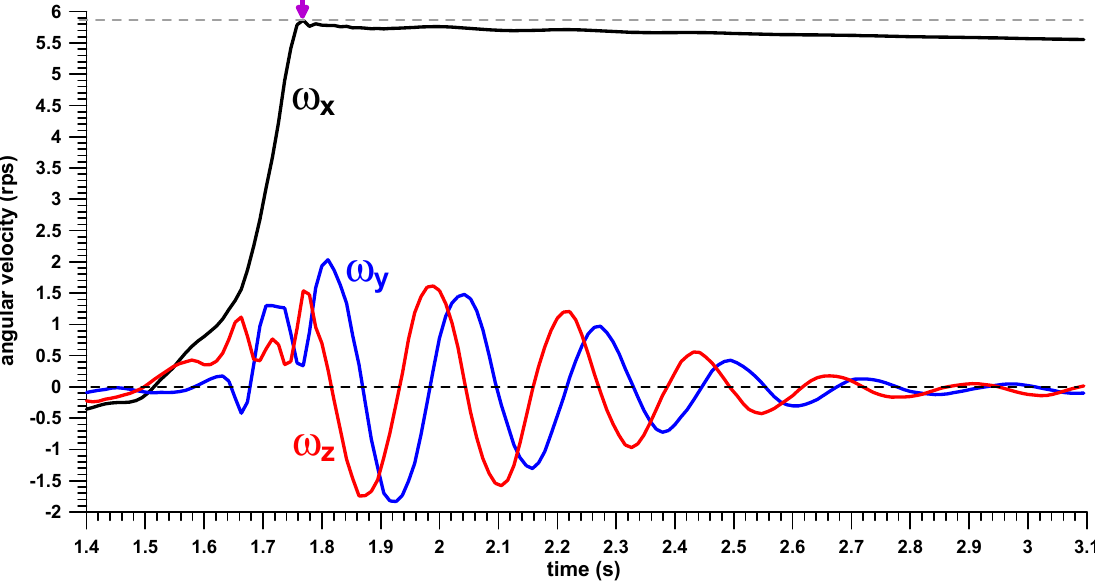
Figure 1. Angular velocity ( ω ) components of the Frisbee against time; the x-component is perpendicular to the plane of the Frisbee; the release point is indicated by a small purple arrow at approximately 1.75